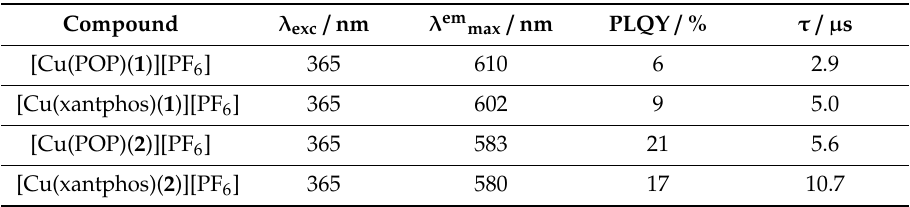
Table 3. Solid-state emission data (298 K) for the copper(I)